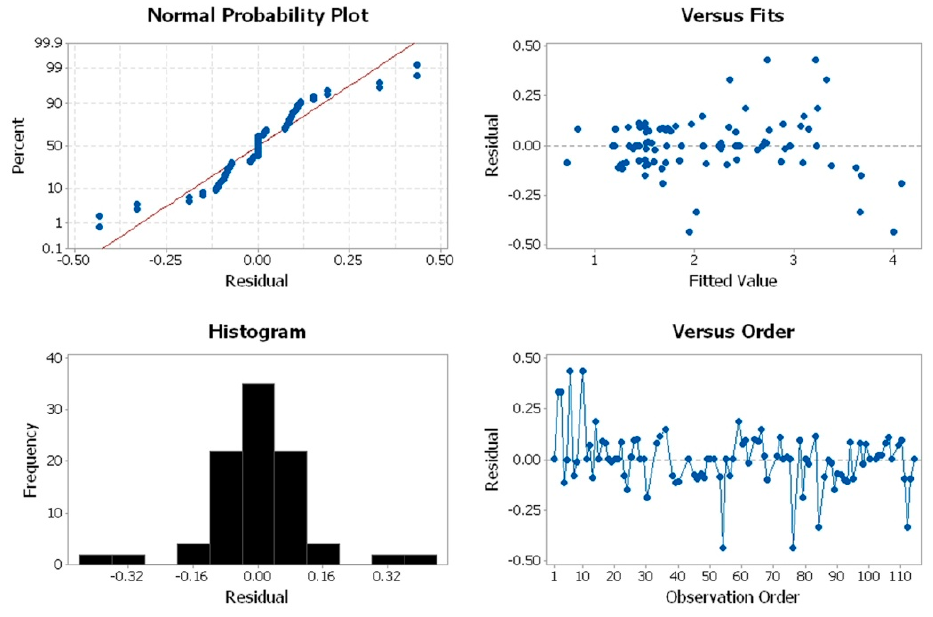
Figure 14. Residual plot for surface roughness (Ra).